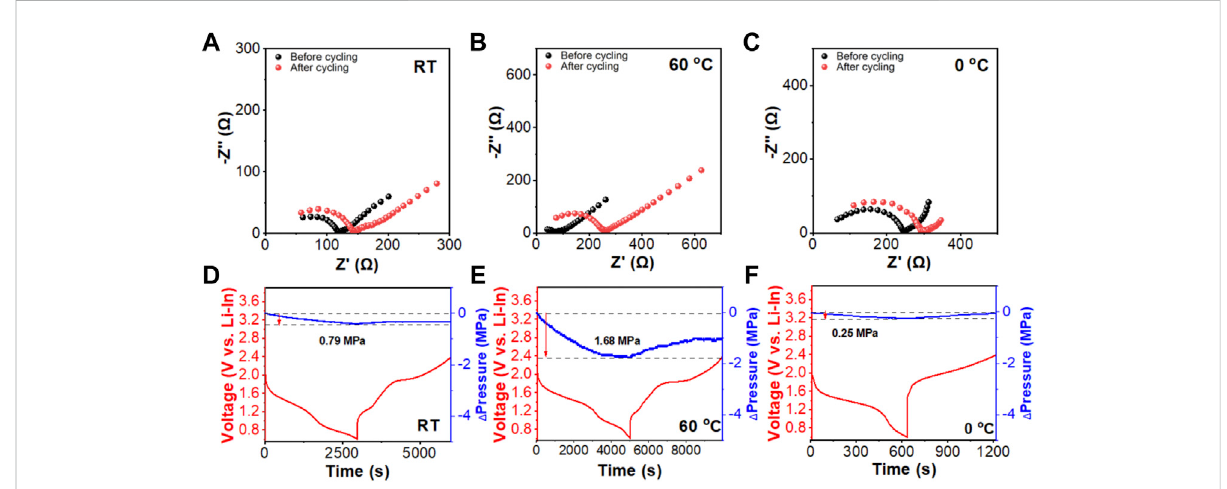
The EIS spectra of the assembled FeS 2 /Li 7 P 3 S 11 /Li-In solid-state battery before and after cycling performance tests at different operating temperatures, (A) RT, (B) 60 ° C,and (C) 0 ° C. In-situ stackpressureevolutionplotsoftheFeS 2 /Li 7 P 3 S 11 /Li-Insolid-statebatterycycledat0.5Cunder (D) RT, (E) 60 ° C, and (F) 0 ° C during the fi rst cycling, respectively.